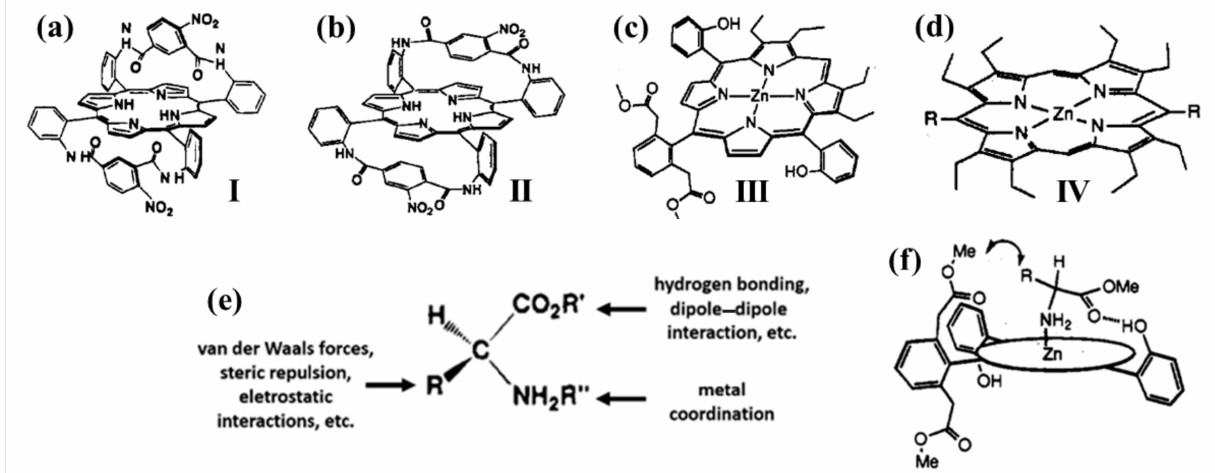
Figure 1. ( a – d ) Structure ( I – IV ) of chiral porphyrins used, from Kuroda et al. Notable, the chirality of IV is brought by the R group; ( e ) Sites of amino acids able to form non-covalent interactions; ( f ) Schematic model of non-covalent interactions between an amino acid and the chiral porphyrin pocket sketched from structure III . Figure 1a,e adapted with permission from reference [56]; published by American Chemical Society 1995. Figure 1b adapted with permission from reference [55]; published by John Wiley and Sons 2003. Figure 1c,f adapted with permission from reference [57]; published by American Chemical Society 1994. Figure 1d adapted with permission from reference [58]; published by American Chemical Society 1993.